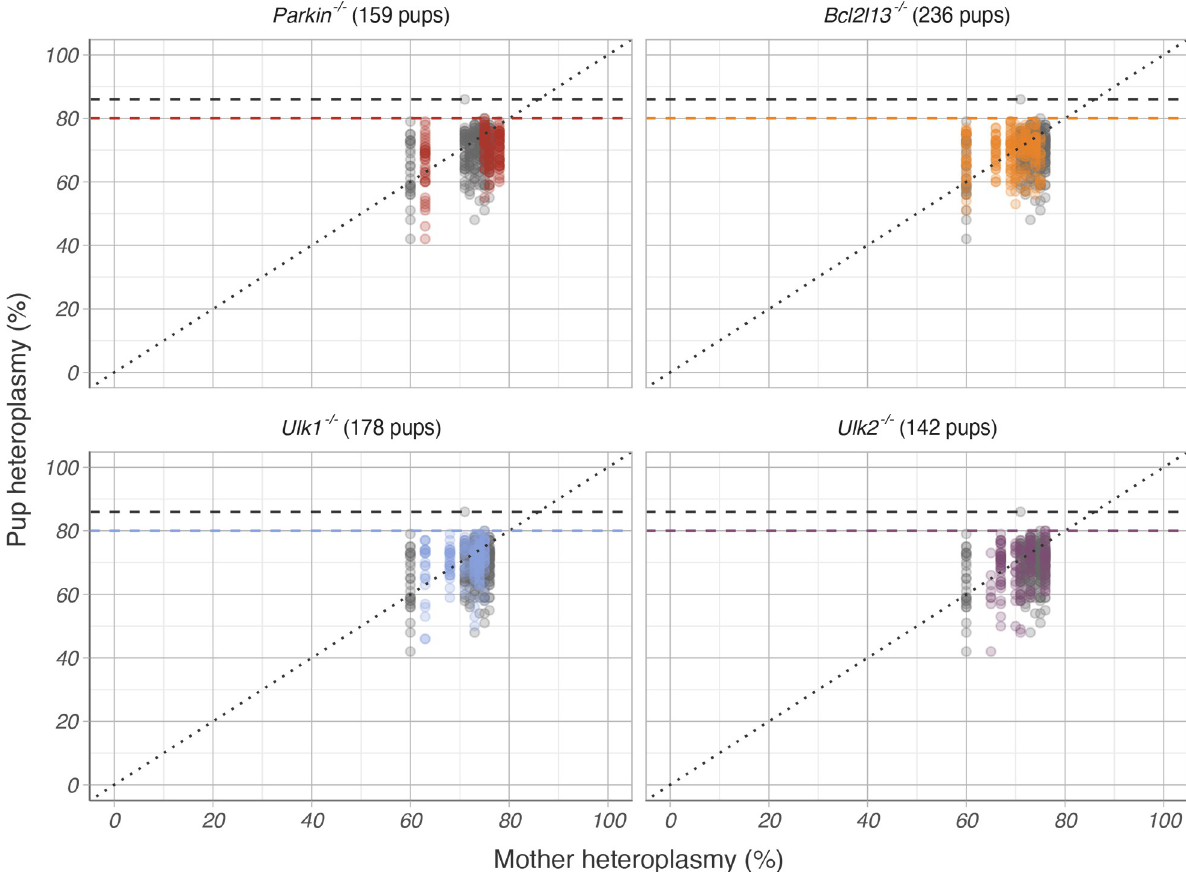
Fig 2. Mother and pup C5024T heteroplasmy across Parkin , Bcl2l13 , Ulk1 and Ulk2 knockout groups. Coloured points correspond to mice with autophagy-mediating gene deletion and grey points correspond to mice from both the Parkin +/+ and Bcl2l13 +/+ controls (274 pups in total). The dashed lines show the highest observed heteroplasmy level in each group (80% for Parkin , Ulk1 and Ulk2 knockout groups, 79% for the Bcl2l13 knockout group, and the outlier 86% for Bcl2l13 +/+ ) . The highest observed heteroplasmy was comparable across all groups.